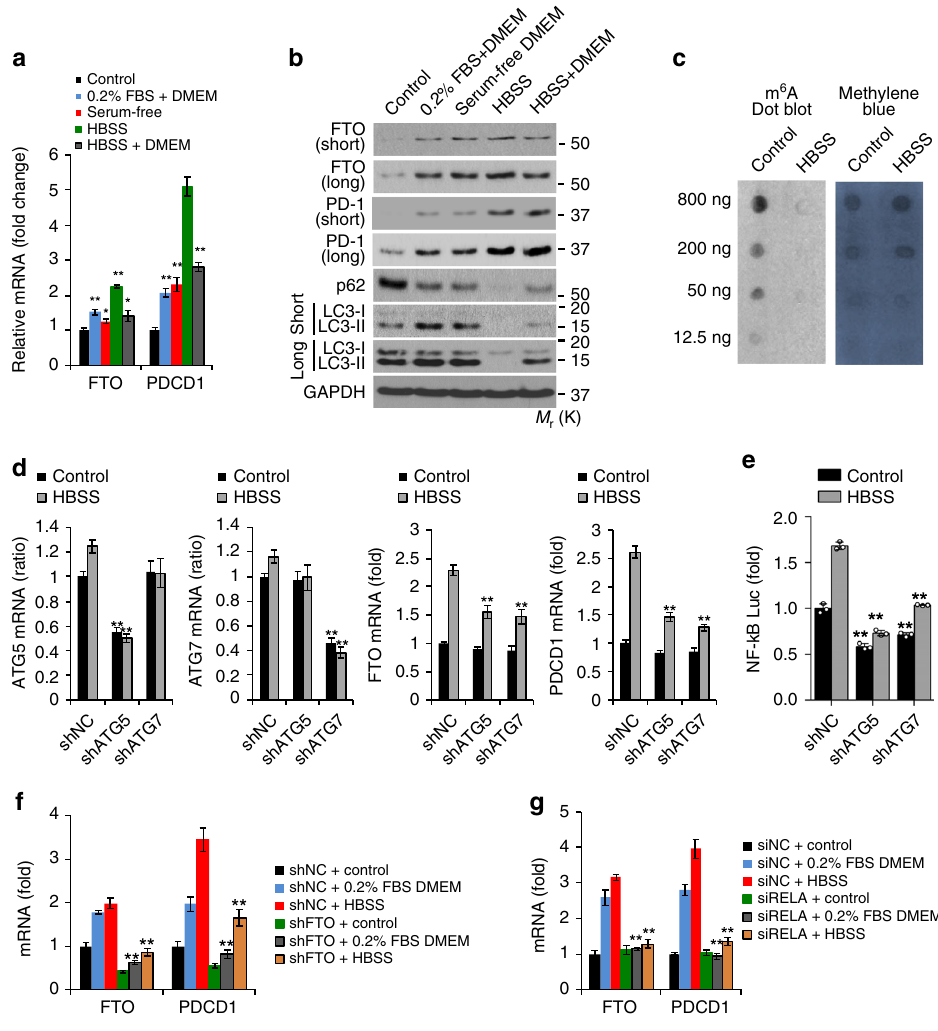
Fig. 7 Metabolic stress induces FTO expression through NF-kB and autophagy. a qPCR analysis of FTO and PD-1 (PDCD1) mRNA levels in Mel624 cells cultured with control medium (10% FBS DMEM), 0.2% FBS DMEM, serum-free DMEM, Hanks ’ balanced salt solution containing calcium and magnesium (HBSS), or a combination of DMEM and HBSS. b Immunoblot analysis of FTO, PD-1, p62, LC3-I/II (short and long exposure), and GAPDH in Mel624 cells treated as in a . c m 6 A dot blot assays using total RNA of Mel624 cultured with control medium or HBSS. Methylene blue staining was used as a loading control. d qPCR analysis of FTO and PD-1 (PDCD1) mRNA levels in Mel624 cells with or without knockdown of ATG5 or ATG7 and with or without metabolic stress. e Luciferase reporter analysis of NF- κ B response element in Mel624 cells as in d . f qPCR analysis of FTO and PD-1 (PDCD1) mRNA levels in Mel624 cells with or without FTO knockdown treated with or without metabolic stress. g qPCR analysis of FTO and PD-1 (PDCD1) mRNA levels in Mel624 cells with or without siRNA knockdown of RELA treated as in e . Data are shown as mean ± S.E. ( a , d , f , g ), or mean ± S.D. ( e ) ( n ≥ 3).* P < 0.05; ** P < 0.01; *** P < 0.001; Student ’ s t